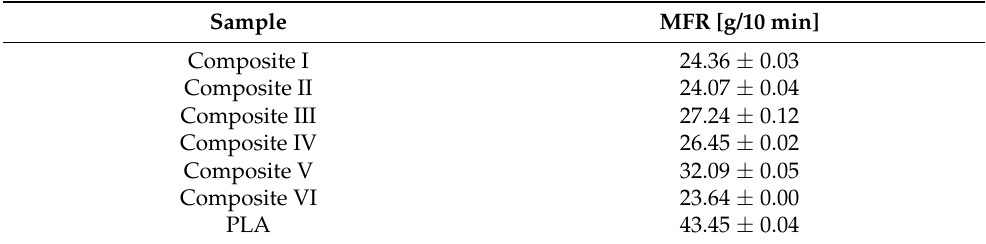
Table 4. Parameters of the MFR test.